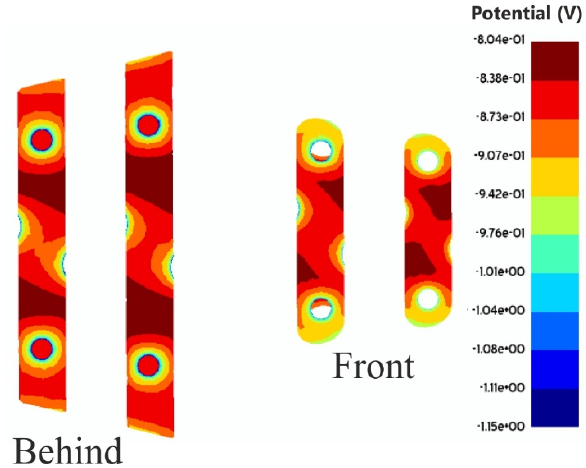
Figure 12. Potential distribution φ (V vs Ag/AgCl/seawater) at the steel tubes of the thrusters.